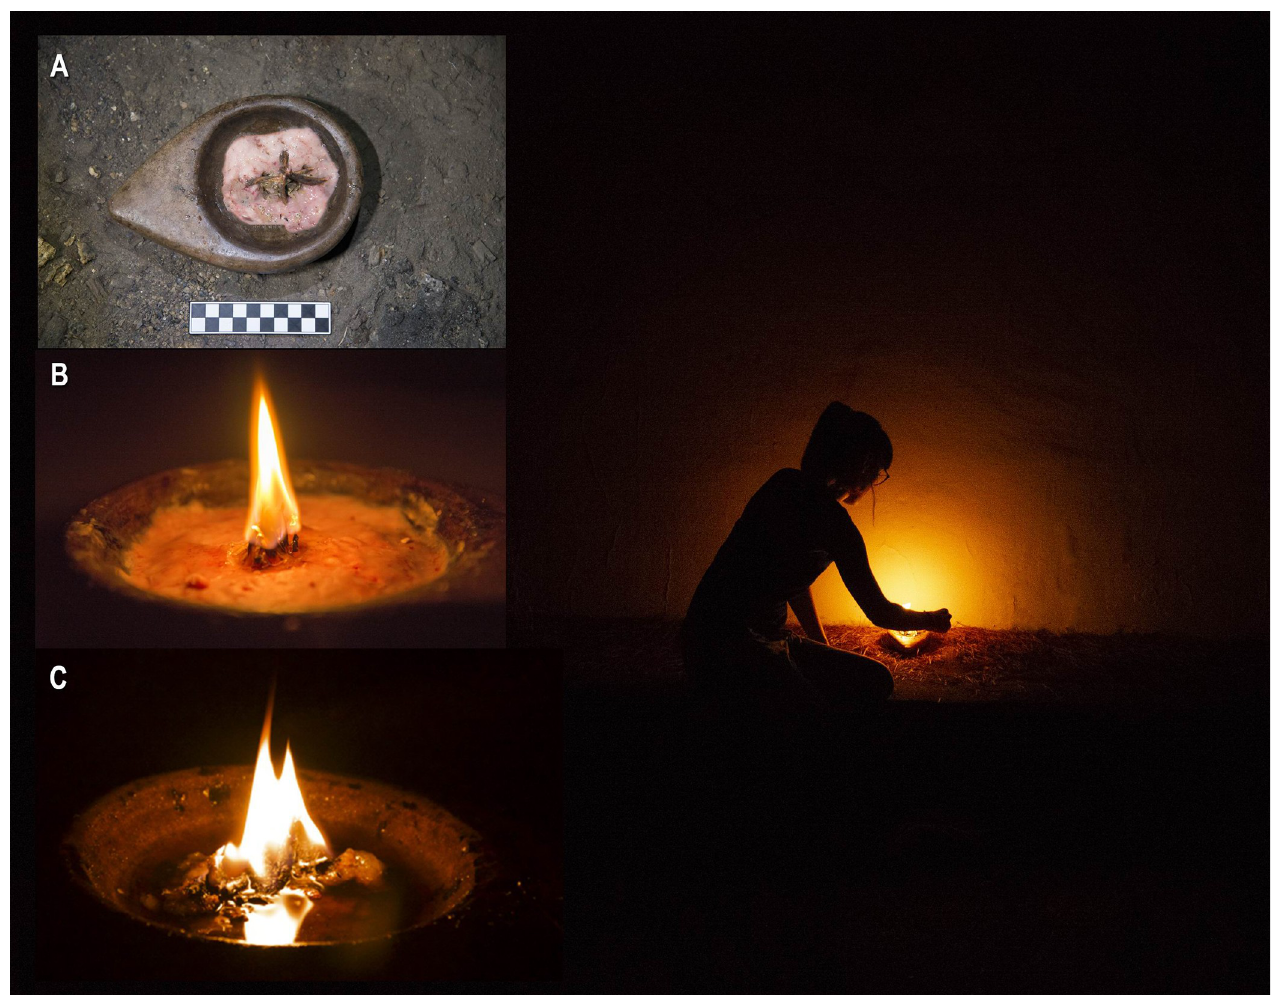
Fig 7. Photograph of experiment 6 with stone lamps. Observe the semicircular arc of light. A. Experiment 6 before being lit. B. Experiment 6 after functioning for 1’. C. Experiment 6 after functioning for 43’.